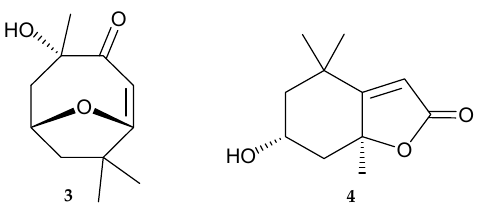
Figure 4. Chemical structures of pubinernoid A ( 3 ) and (+)-loliolide ( 4 ).